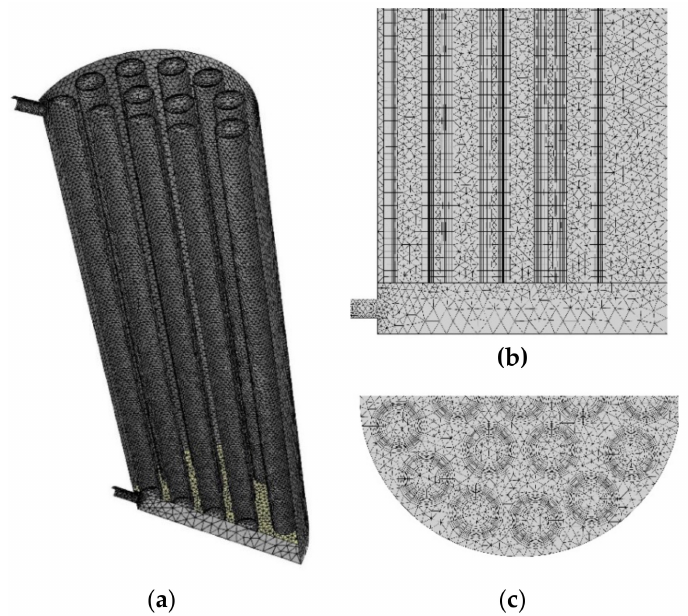
Figure 12. Geometry of the PCM enhanced Tank, ( a ) geometry with surface grid, ( b ) bottom grid with inlet plenum, ( c ) mid-height section of the model.